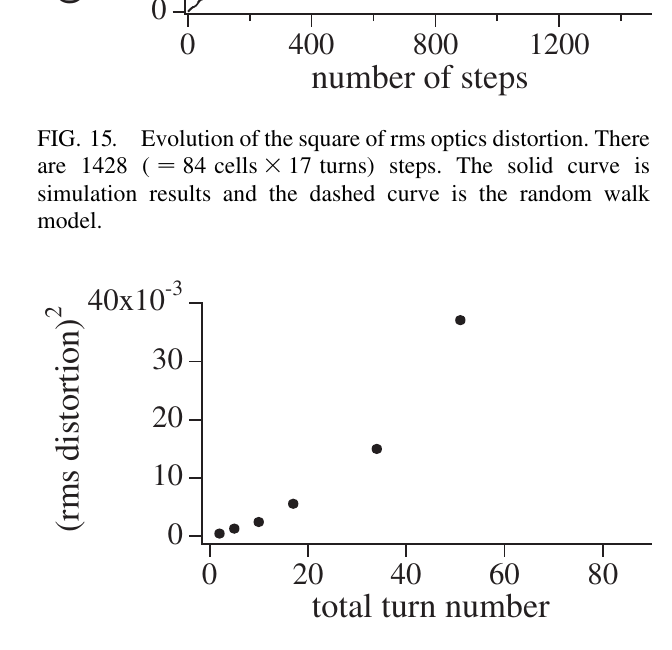
FIG. 16. Square of rms distortion for different acceleration rate.